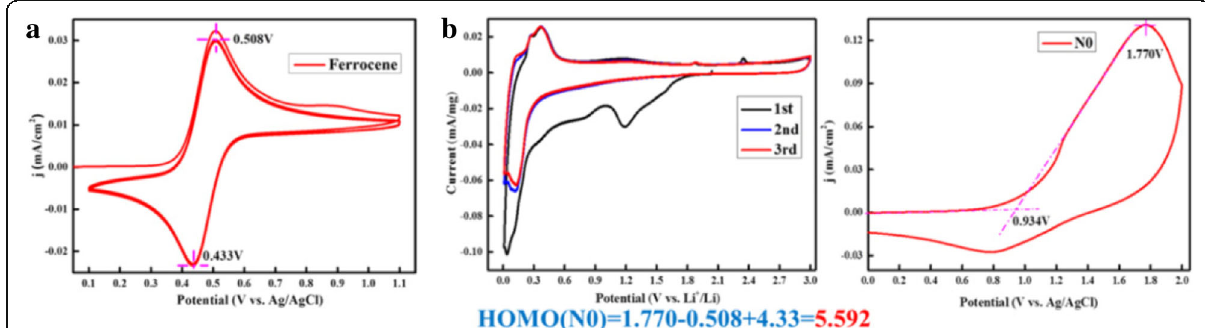
Fig. 6 Cyclic voltammograms (CVs) of ferrocene current collector disc vs. silver metal in the electrolyte ( a ) without additive, and b oxidation energy HOMO values in acetonitrile using tetrabutylammonium perchloride as